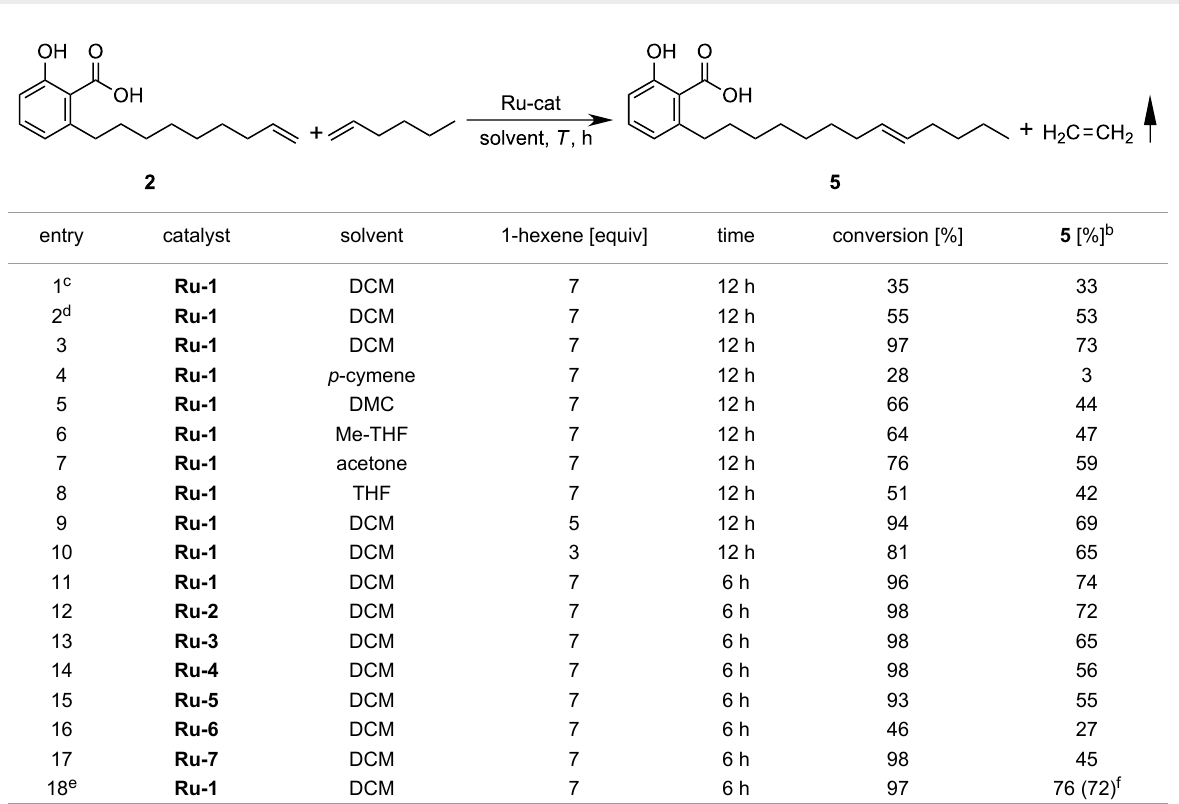
Table 1: Cross-metathesis of 2-hydroxy-6-(non-8-enyl)benzoic acid ( 2 ) with 1-hexene. a